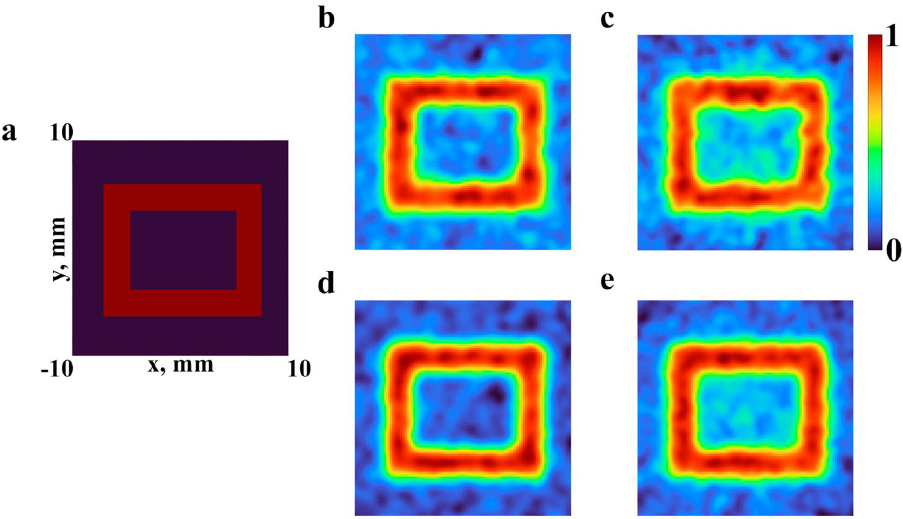
Figure 4. Results of a numerical experiment for ghost imaging. Reference object ( a ), reconstructed images from data with a monochromatic radiation ( b , d ) and wide spectrum ( c , e ) for 10 ( b , c ) and 20 ( d , e ) thousand